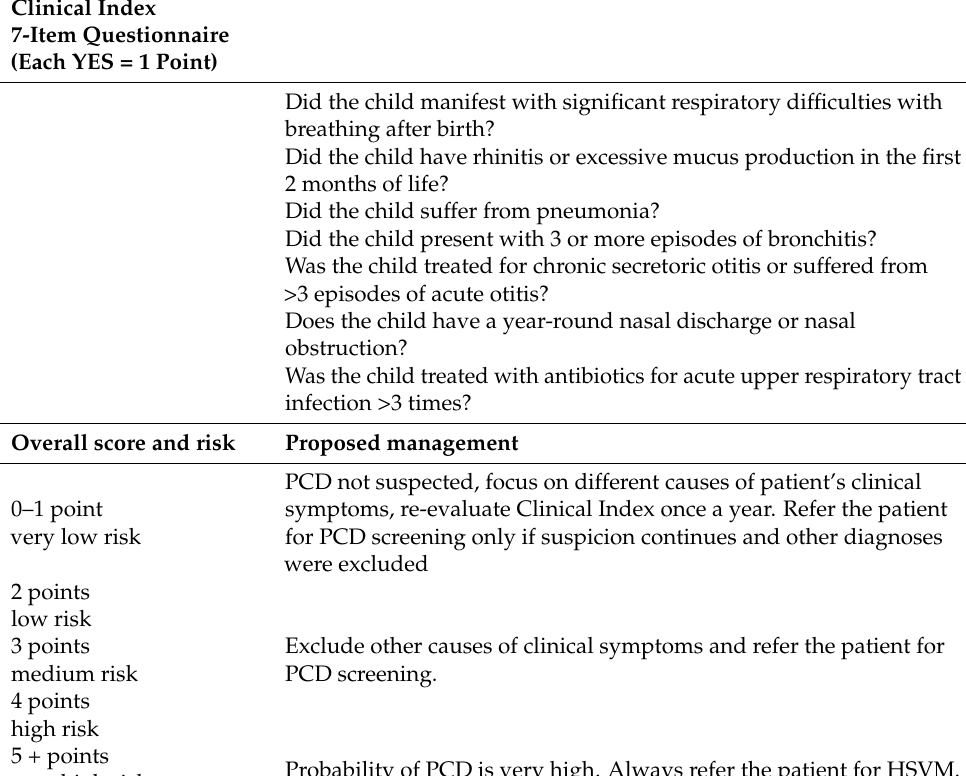
Table 1. Clinical Index: Seven-item questionnaire